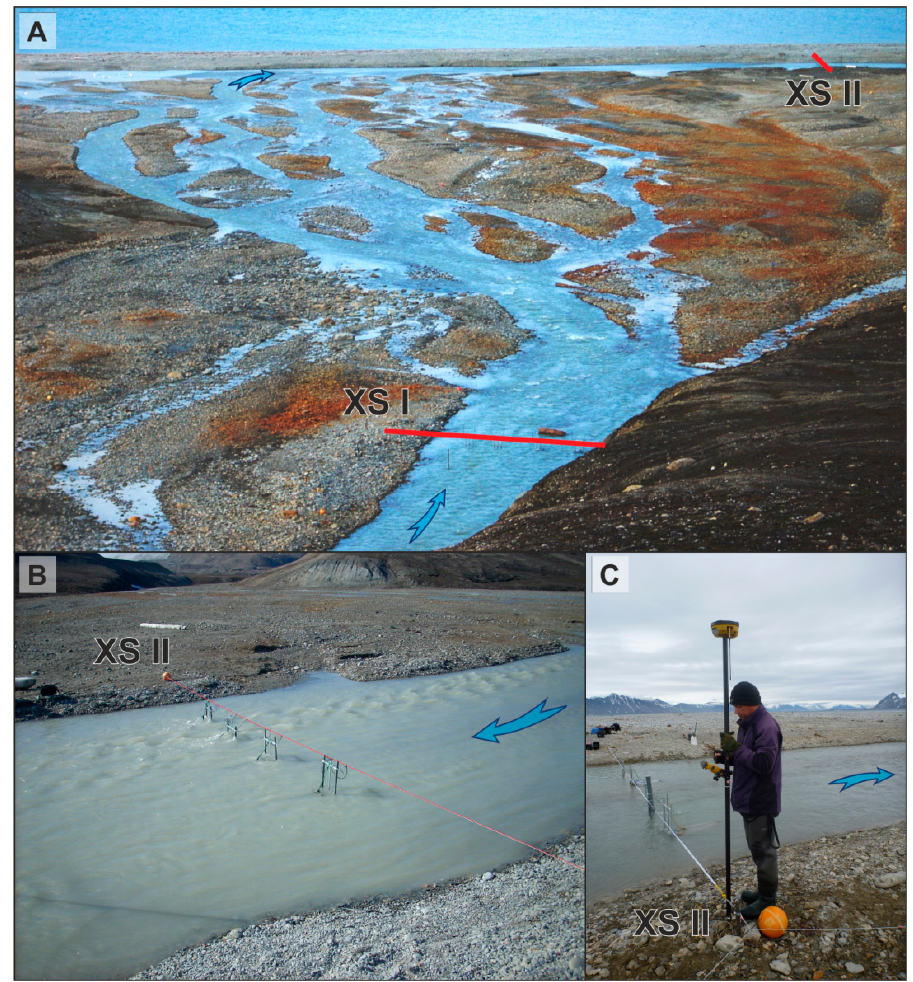
Figure 2. ( A ) Downstream view of the lower part of the Scott River valley (in the foreground is the location of cross-section—XS I where the gorge is cutting through lifted marine terraces); ( B ) upstream view of the second cross-section—XS II; ( C ) an example of the GNSS survey in the